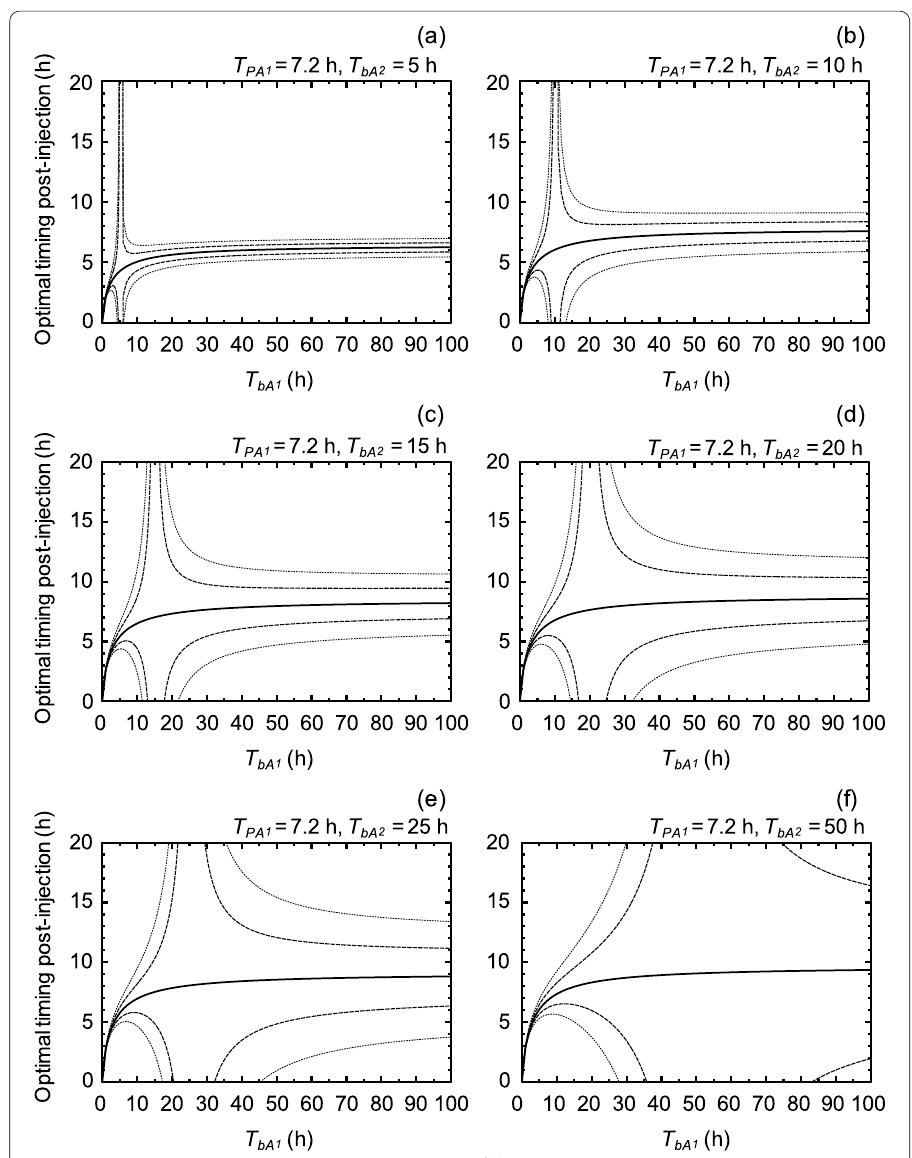
Fig. 3 Behavior maps of an optimal timing (solid line) on 211 At-labeled target compounds. T pA1 and T bA 1 are the physical HL and HL of the biological clearance of a target, respectively. T bA 2 is the half-life of the biological clearance of a reference. Behavior maps of T bA 2 in these cases of 5, 10, 15, 20, 25, and 50 h are presented in the panels of ( a ), ( b ), ( c ), ( d ), ( e ), and ( f ), respectively. The dashed and dotted lines represent optimal timing in the cases of 0.95 and 1.05, and 0.9 and 1.1 times converted absorbed doses,